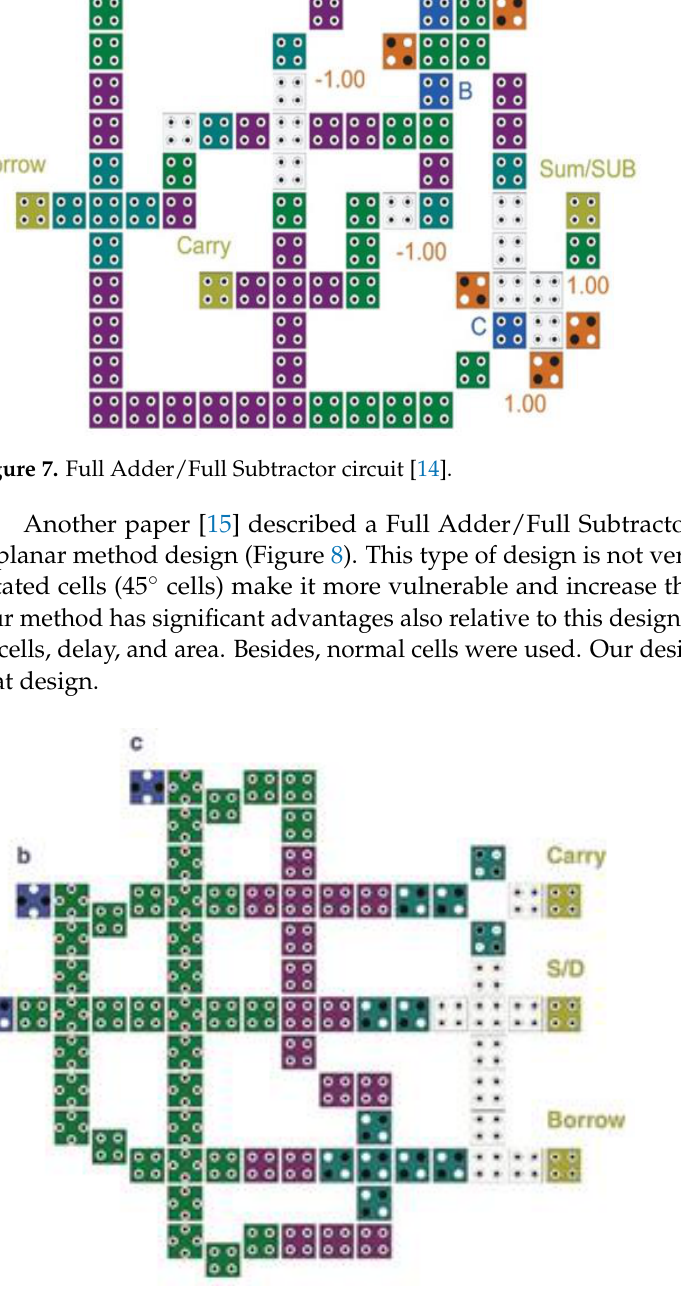
Figure 6. Full Adder/Full Subtractor circuit [13].